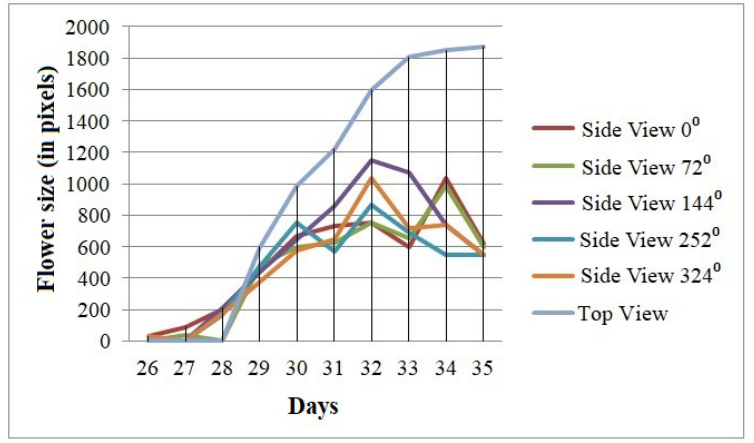
Figure 17. Illustration of the growth trajectory of a canna flower in multiple views (Plant-ID: Canna-D1).